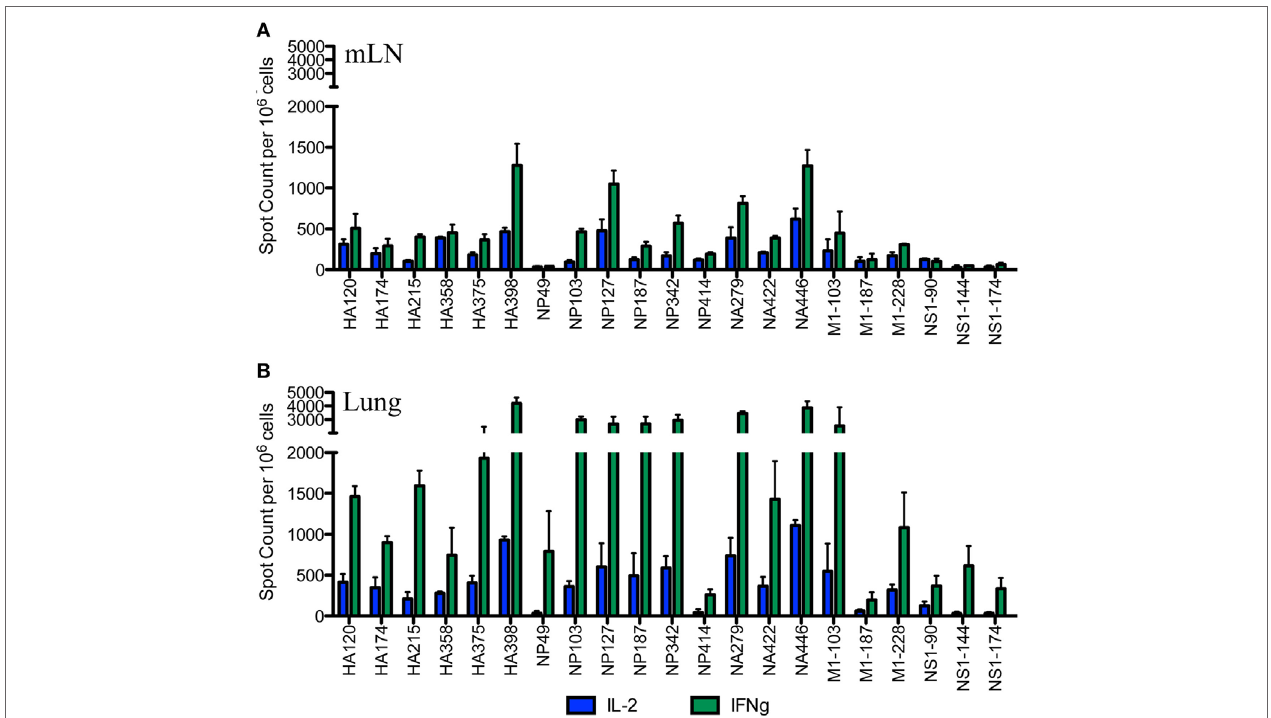
FigUre 2 | Broad CD4 T cell specificity identified in the draining lymph node (dLN) is maintained at the site of infection. Female A/J mice were infected intranasally with 50,000 EID 50 of A/New Caledonia/20/99 H1N1 virus. The number of virus peptide-specific IL-2 producing (blue) and IFN- γ producing (green) CD4 T cells were quantified at days 10–11 postinfection in CD4 T cells using cytokine EliSpots. Cells isolated from mediastinal lymph nodes (mLN) are indicated in (a) and from the lung in (b) . Results are represented as cytokine-producing spots per million CD4 T cells and represent mean ± SD of three independent